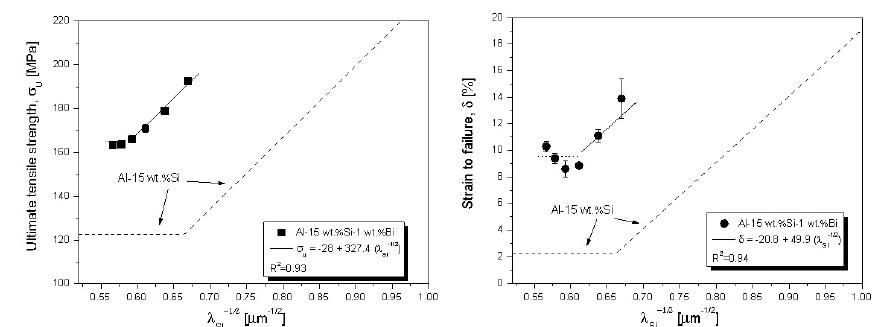
Figure 5. Evolutions of ultimate tensile strength and strain to failure along the length of the DS Al-15 wt. %Si -1.0 wt. %Bi alloy as a -1/2 . R 2 is the coefficient of determination related to the adjusted curves. function of the inverse of the square root of the Si spacing, λ Si